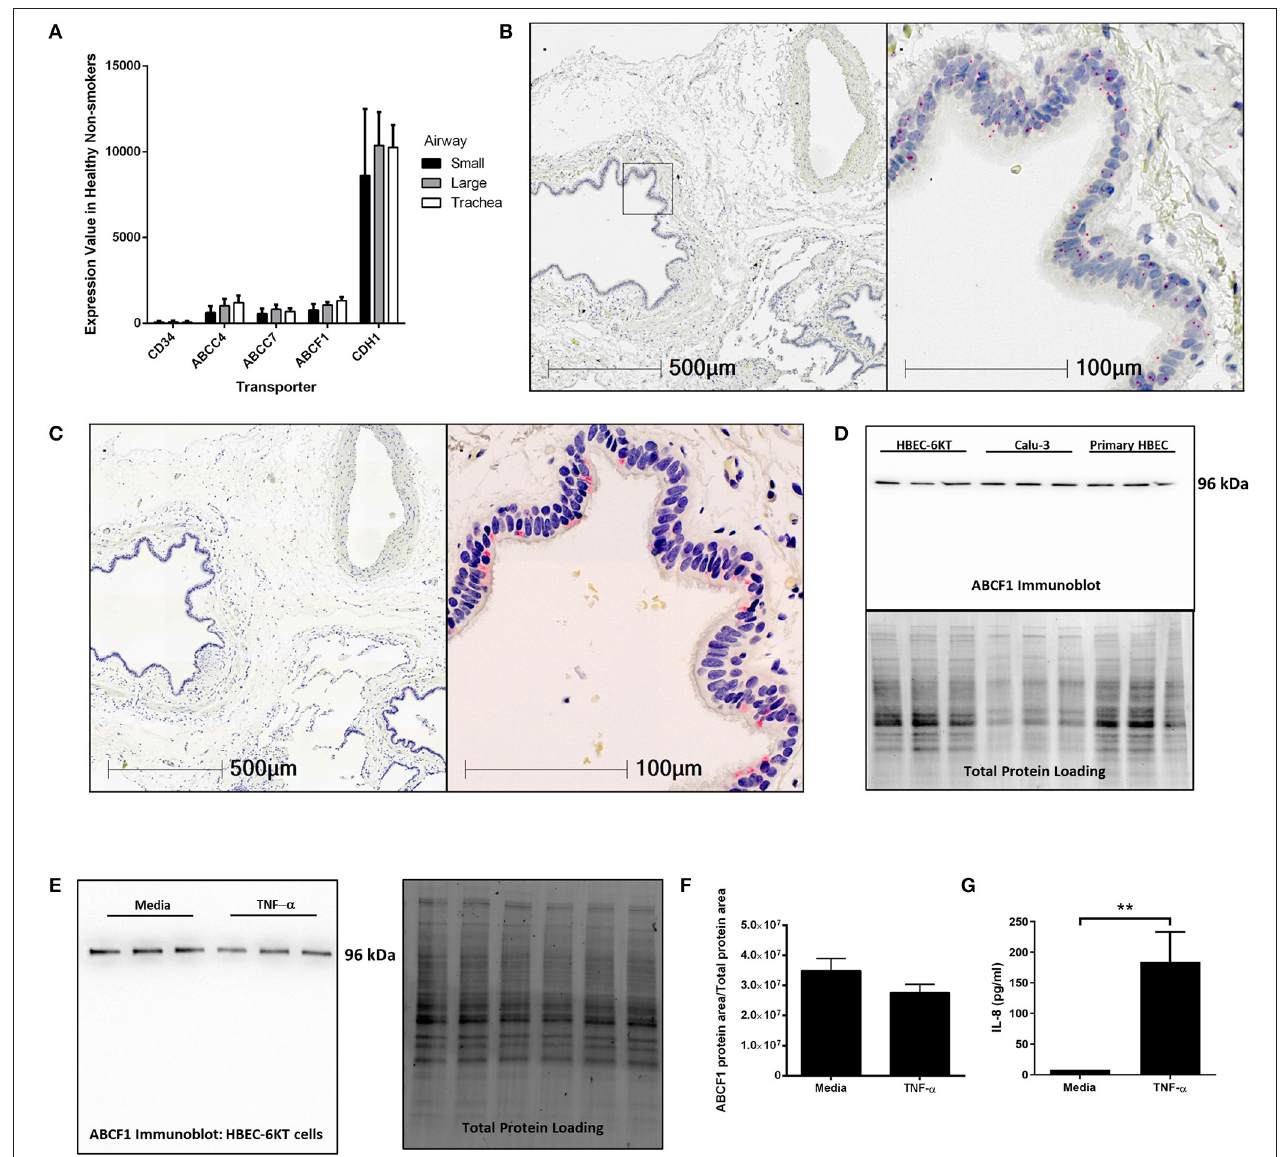
FIGURE 1 | Validation of ABCF1 gene and protein expression in human airway epithelial cells in situ and in vitro . (A) Gene expression analysis of GEO deposited microarray dataset (GSE11906) generated from epithelial cells isolated from trachea, large (2 nd -3 rd generation), and small airways (10 th –12 th generation) from healthy subjects (see Methods for details). (B) In situ hybridization of ABCF1 RNAscope TM probe in human lung under low (10X) and high (40X) magnification. Red puncta are representative of ABCF1 gene transcripts with nuclei counterstained blue. Representative image of n = 10. (C) Immunohistochemistry of ABCF1 in human lung under low (10X) and high (40X) magnification. Representative image of n = 10. Pink/red staining is representative of ABCF1 protein with nuclei counterstained blue. (D) Immunoblot confirmation of ABCF1 protein expression in HBEC-6KT, Calu-3, and primary human airway epithelial cells (each cell type n = 3 distinct cell line passages or donors) with a single band observed at predicted molecular weight (96kDa) with total protein loading blot demonstrating equal protein loading for each cell type. (E) Immunoblot of ABCF1 following TNF- α stimulation of HBEC-6KT cells with corresponding total protein stain. (F) Quantification of immunoblot of ABCF1 protein expression. (G) IL-8 secretion from HBEC-6KT cells measured by ELISA as positive control for TNF-a stimulation. All studies n = 3 unless otherwise noted. ** p < 0.01.